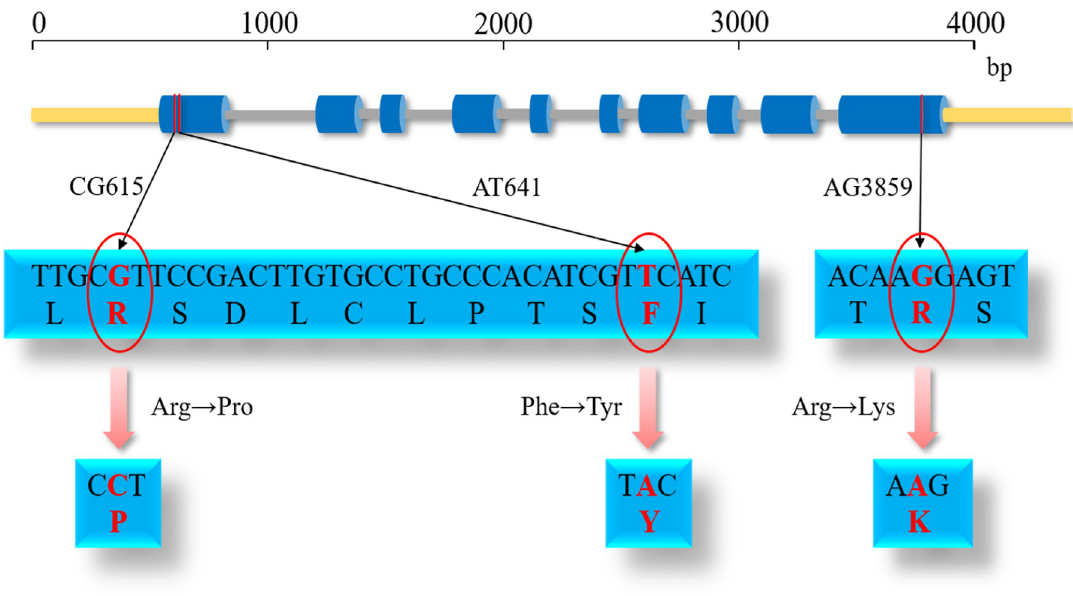
Fig 6. Molecular mechanism underlying the effects of the three TagSNPs on α -pinene